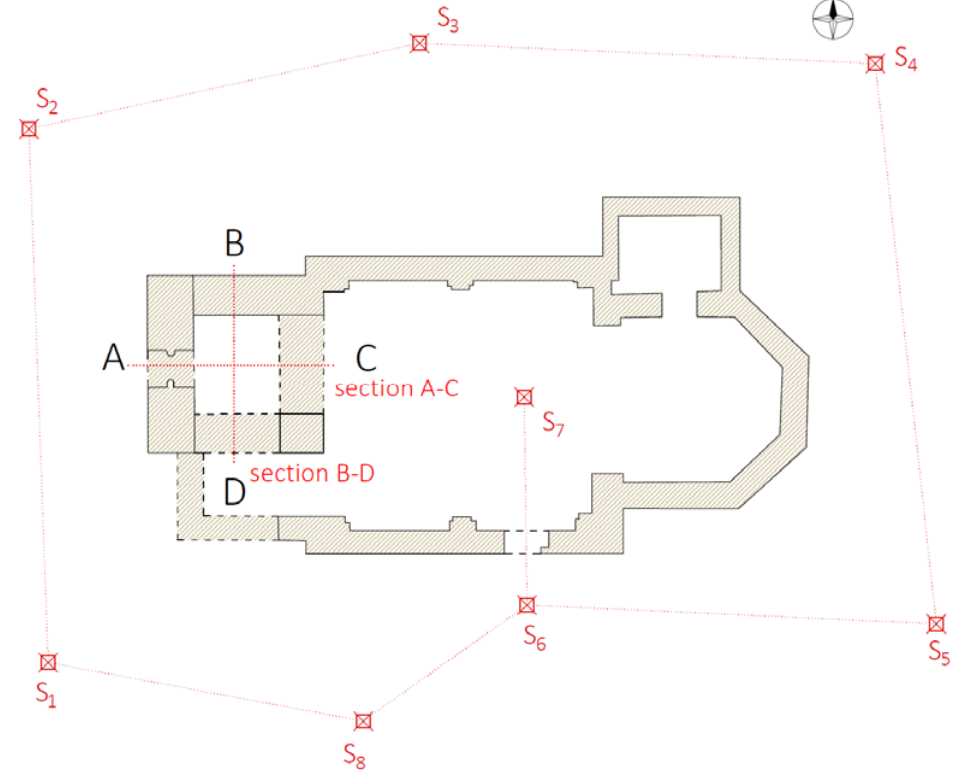
Figure 2. The scheme of the measurement. S1–S8 are the TLS station positions, and A–D are the observed tower walls.